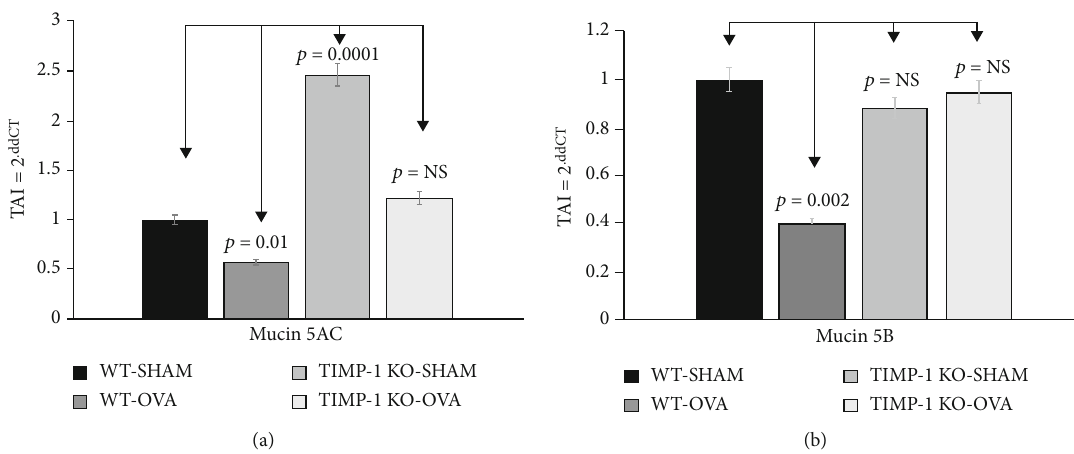
Figure 2: Secreted mucins MUC5AC and MUC5B gene expression levels in lung tissue obtained from OVA-sensitized TIMPKO, OVA- sensitized TIMPKO, OVA-sensitized WT, and WT-SHAM mice. Comparative real-time qPCR analysis showing relative gene expression of MUC5AC and MUC5B in lung tissue of OVA-sensitized TIMPKO, OVA-sensitized TIMPKO, OVA-sensitized WT, and WT-SHAM mice. Data normalized to the housekeeping gene β -actin and with WT-SHAM as control. Gene expression was calculated using the comparative CT method. Results are expressed as the mean ± SD , n = 3 separate